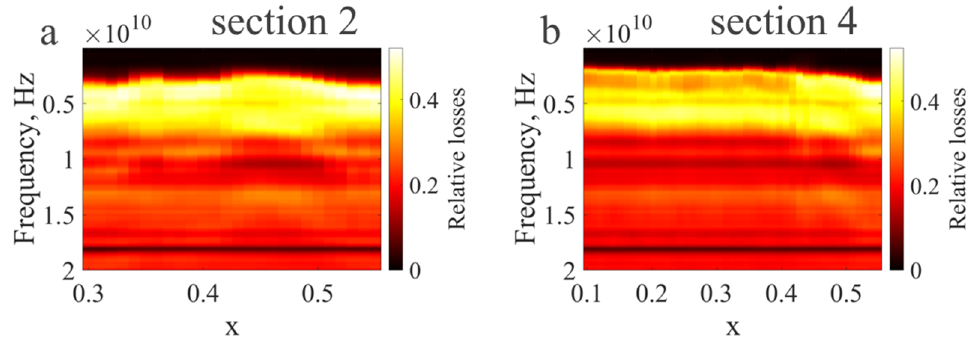
Figure 9. Dependence of the absorption coefficient on the frequency and composition of samples of the 2nd ( a ) and 4th ( b ) sections of the system.